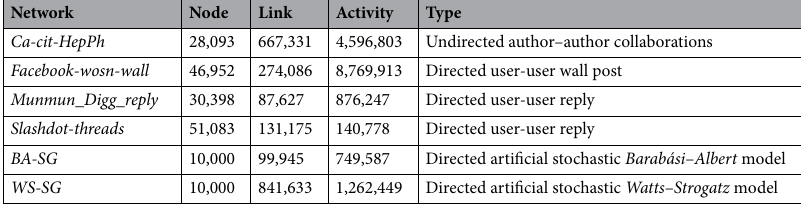
Table 1. Test Networks for The Experimentation. All real networks are freely available at http:// konect. cc/ netwo